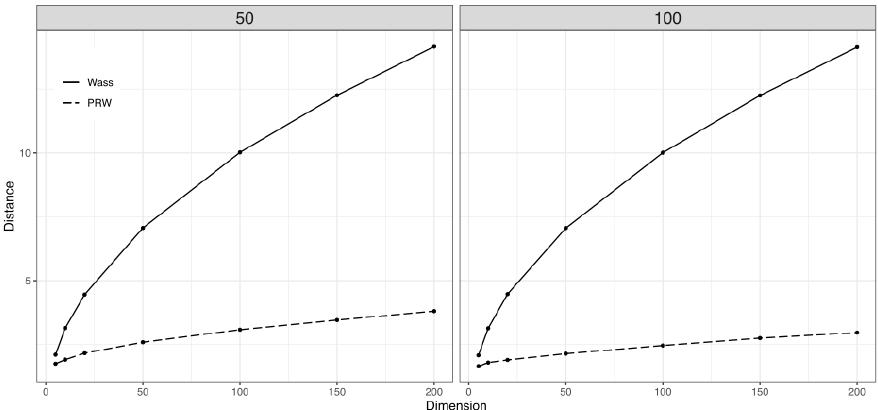
Figure 1. Various type of Wasserstein distances depending on the dimension N